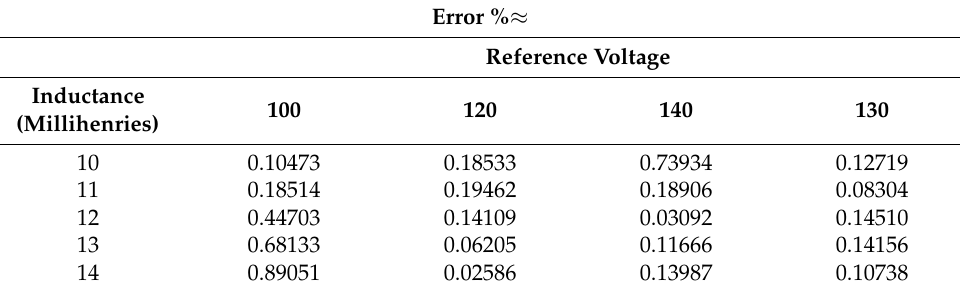
Table 4. Percentage error in the output voltage due to changes in the